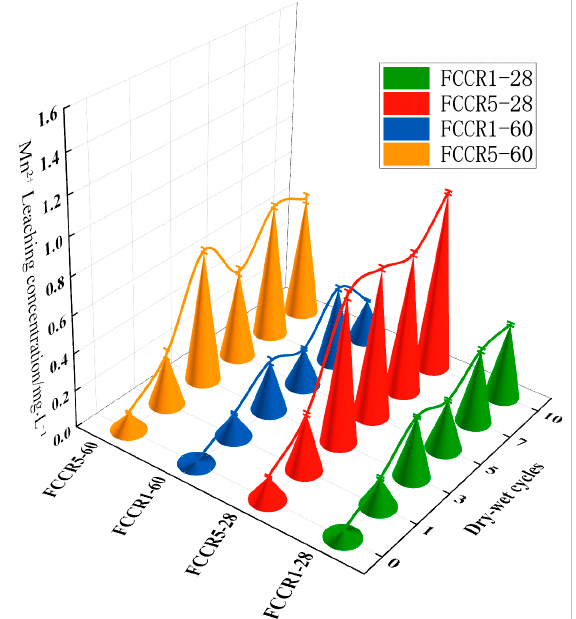
Figure 7. Leaching Mn 2+ concentration under different durability conditions.